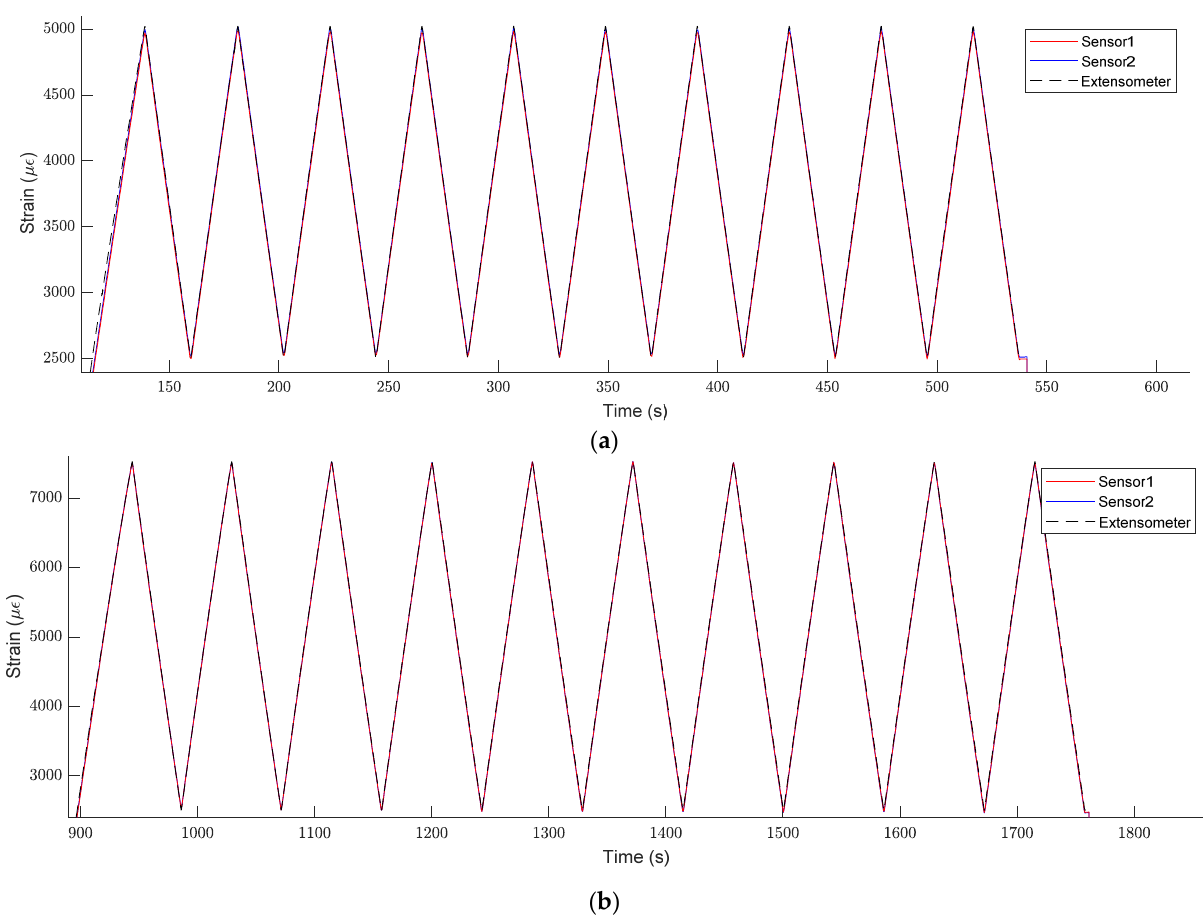
Figure 7. Tensile strain cycles: ( a ) 0.25–0.50% strain cycles; ( b ) 0.25–0.75% strain cycles.